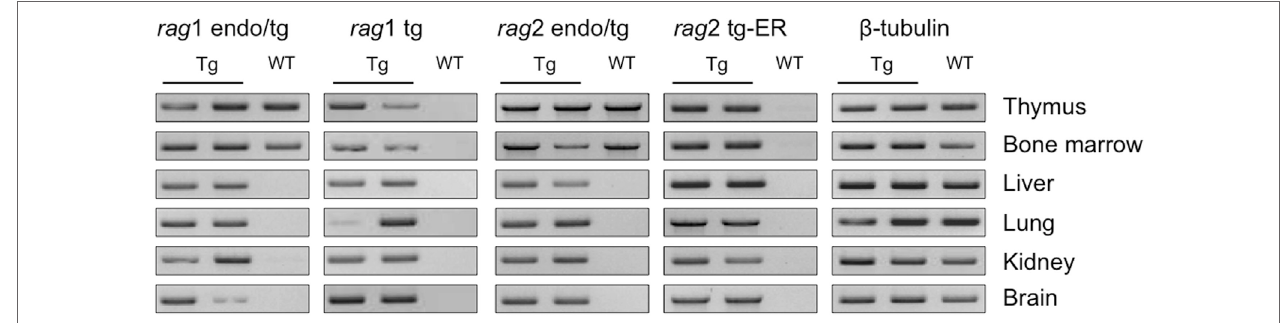
FigUre 1 | rag transgenes are transcribed in lymphoid and non-lymphoid tissues of Tg mice. rag 1, rag 2 and β -tubulin transcripts were detected by RT-PCR in thymus, bone marrow, liver, lung, kidney, and brain from one wild-type (WT) and two Tg endoR2 + / + mice. Primers endo/tg detect both endogenous and transgenic rag transcripts. Results are representative of three independent experiments analyzing five different